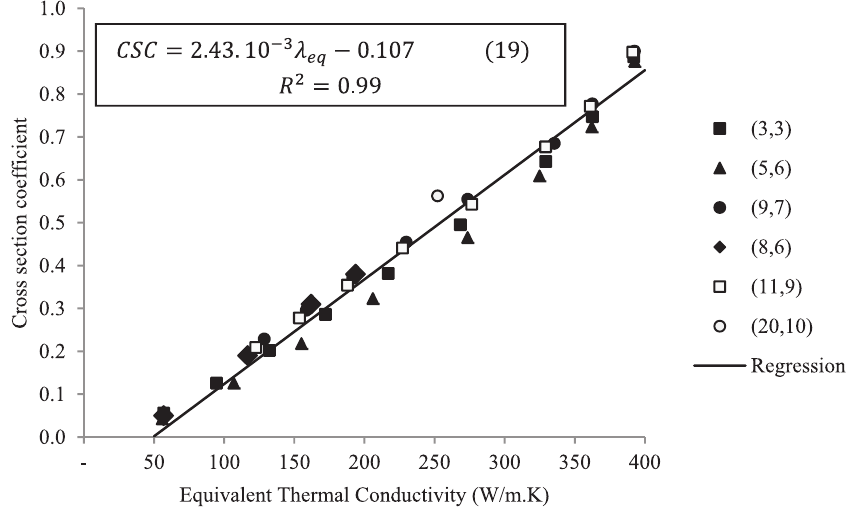
Fig. 11: Evolution of CSC according to λ eq , and linear